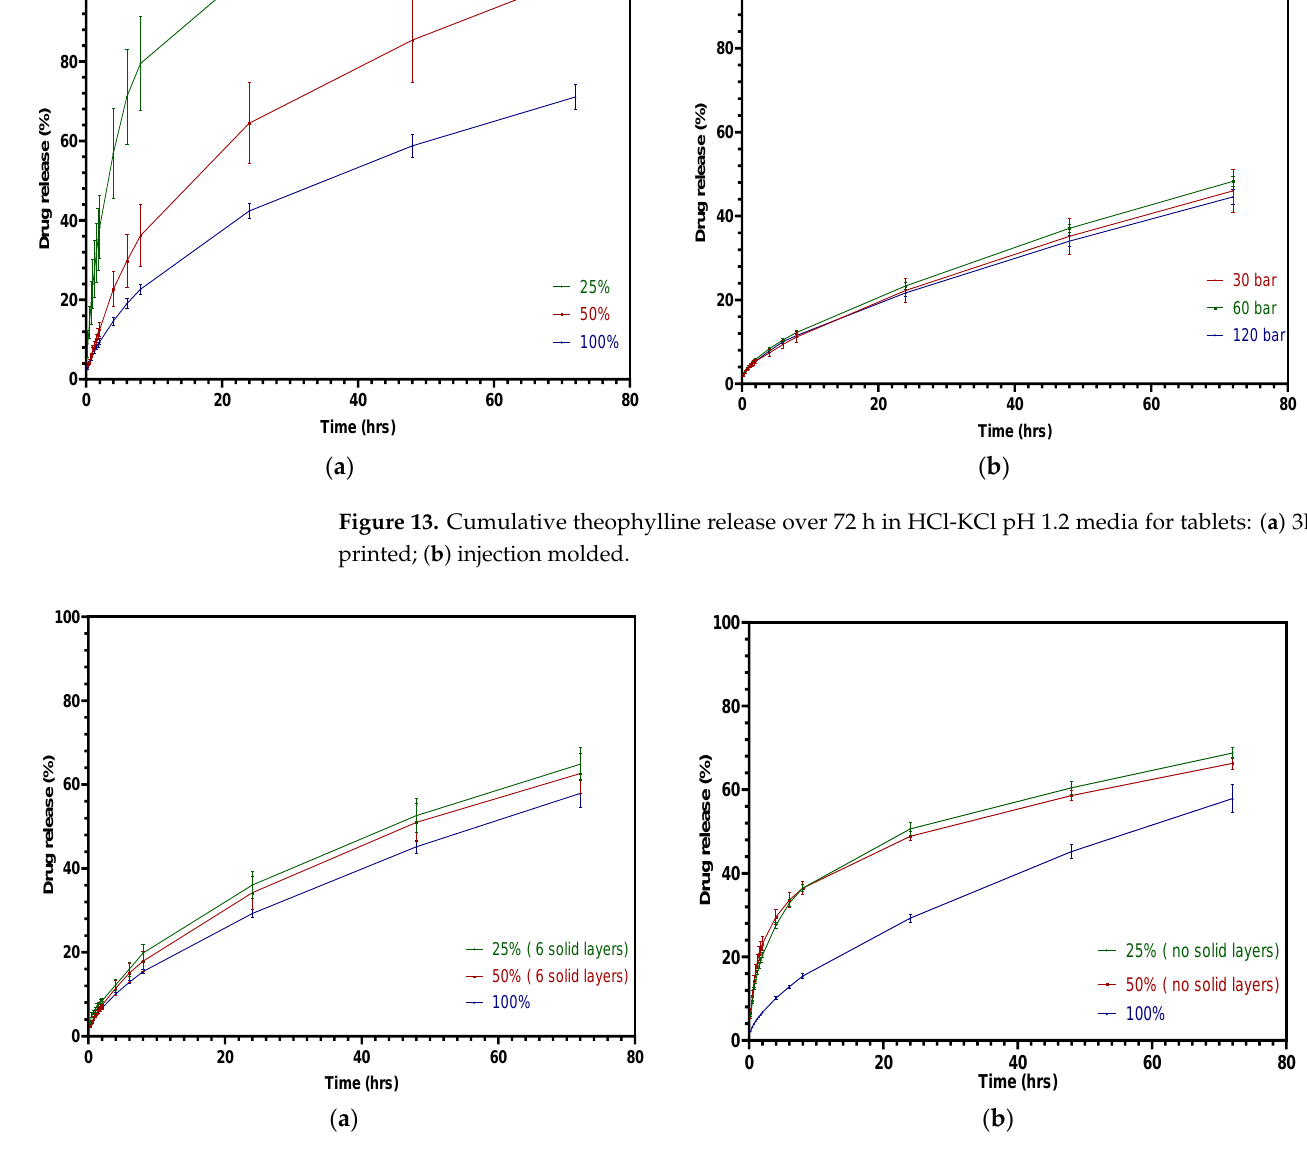
( b ) Figure 15. Cumulative theophylline release over 24 h in HCl-KCl pH 1.2 media for tablets: compar- ison among three different manufacturing approaches. ( a ) Slowest; ( b ) fastest.